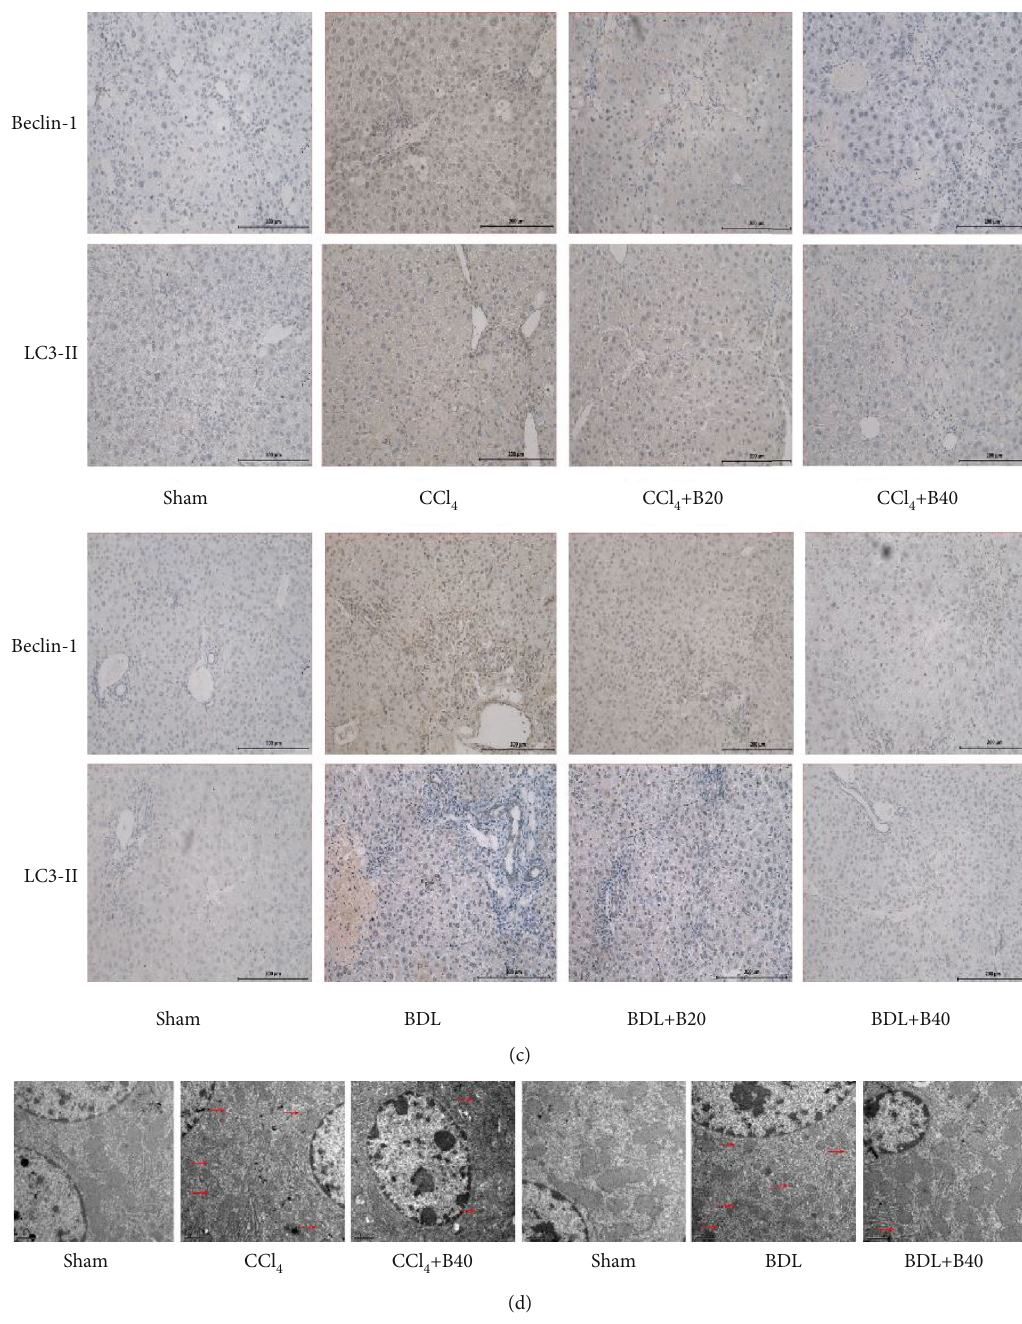
Figure 3: Bergenin decreases autophagy by downregulating Beclin-1 and LC-3. (a) mRNA expression of Beclin-1 and LC3-II assessed by real- time PCR ( n = 8 ). (b) Protein expression of Beclin-1 and LC3-II assessed by western blotting. The quantitative evaluation was determined by relative band density. (c) Immunohistochemical staining of Beclin-1 and LC3-II (original magnification = 200x ). (d) The amount of autophagosome signi fi cantly decreased as showed by TEM (original magni fi cation: × 10000). ∗ p < 0 : 05 for CCl /BDL vs. sham, # p < 0 : 05 4 for CCl /BDL+B20 vs. CCl /BDL, and ^ p < 0 : 05 for CCl /BDL+B40 vs. CCl 4 4 4 4